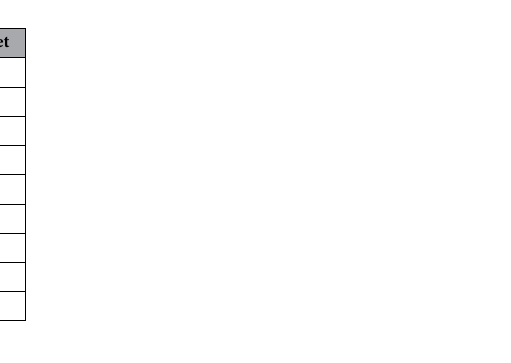
Figure 5. Process of M-SDE_EnELM.